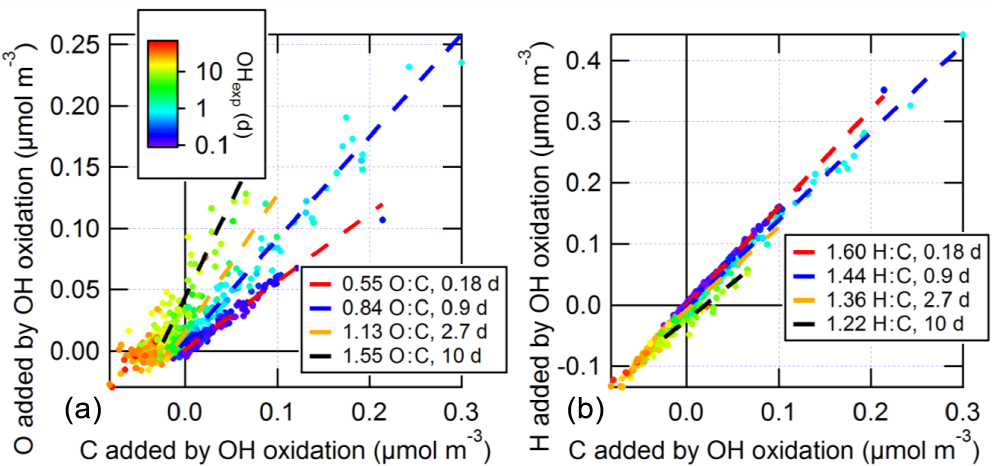
Figure 8. Scatter plots ofµmolm − 3 O andµmolm − 3 H added perµmolm − 3 C added from OH oxidation of ambient air in the OFR. Slopes are fit to the photochemical age ranges of 0.1–0.4 (avg. = 0.18) days, 0.4–1.5 (avg. = 0.9) days, 1.5–5 (avg. = 2.7) days, and 5–15 (avg. = 10) days, showing that the atomic O:C (H:C) ratios of the SOA mass formed in those ranges were 0.55 (1.60), 0.84 (1.44), 1.13 (1.36), and 1.55 (1.22) respectively. At higher ages, heterogeneous oxidation led to loss of C and H and little to no loss of O.